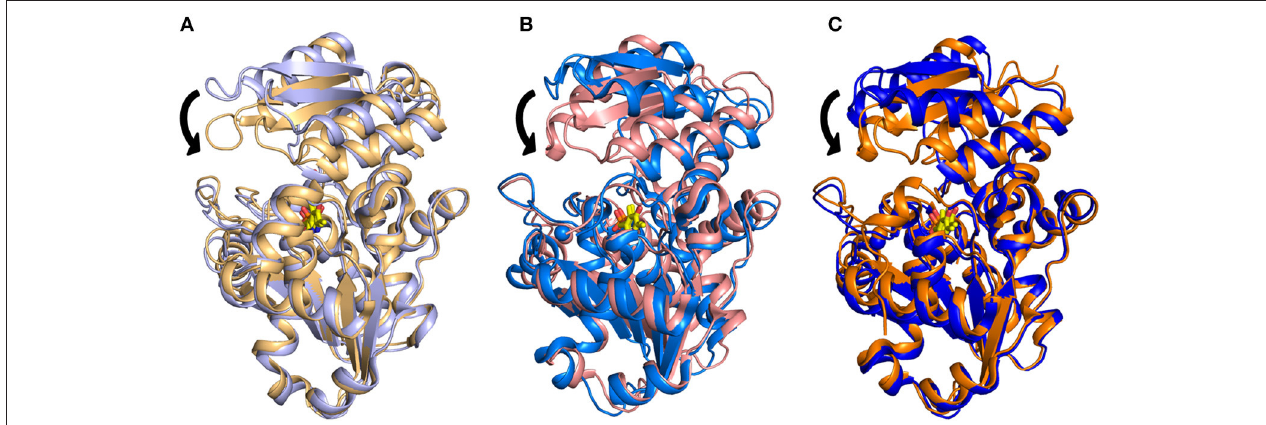
FIGURE 2 | Overlay of (A) the open (PDB 1V71, light purple) and closed (PDB 2ZR8, light orange) structures of SpSR; (B) the open (PDB 3HMK, light blue) and closed (PDB 3L6C, light pink) structures for rat SR; (C) the open (PDB 5X2L, blue) and closed (PDB 3L6B, orange) structures of hSR. PLP is in yellow sticks. The divalent cation is reported as a sphere with the same color code of the cartoon representation. The major conformational change occurring upon ligand binding, i.e., a 20 ◦ hinge movement of the small domain toward the large domain, is indicated by arrows.